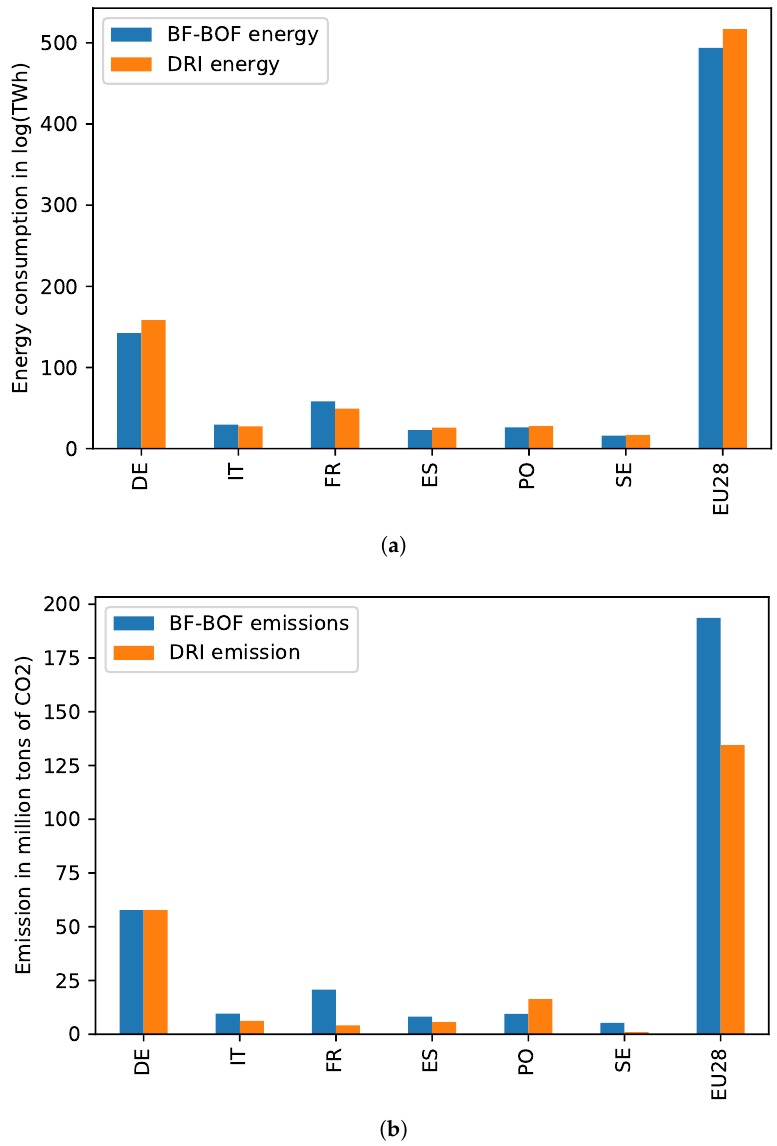
Figure 13. ( a ) Comparison of present energy demand from primary steel production in EU countries and projected energy demand for conversion to hydrogen direct reduction of iron ore (HDRI)-EAF based steel production. ( b ) Comparison of present emissions from primary steel production in EU countries and projected emissions for complete conversion to HDRI-EAF based steel